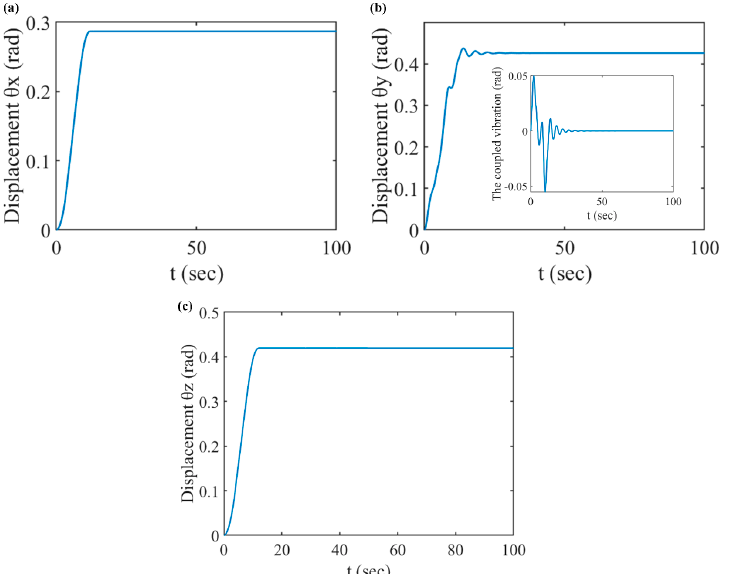
Figure 7. The a tt itude motion of the spacecraft under the τ ( k ⋅ m= 50N / rad ); they are listed as: ( a ) the displacement of